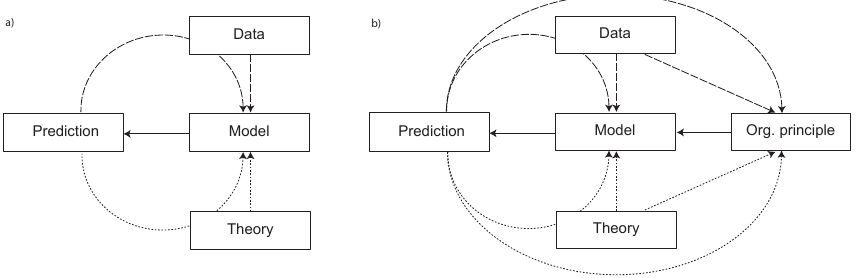
Fig. 4. (a) Classical bottom-up (dotted lines) and top-down (dashed lines) model development approach (inspired from Sivapalan, 2005); (b) new behavioral